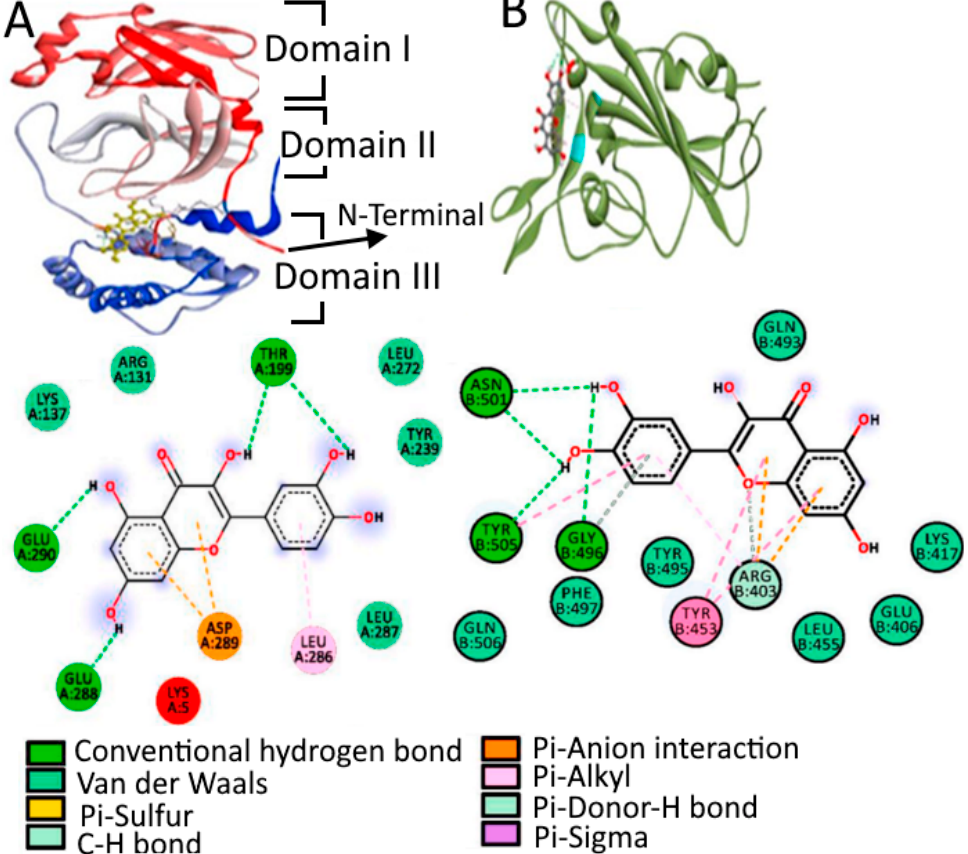
Figure 6. ( A ) Binding mode of M pro with quercetin via amino acid interactions and ( B ) binding mode of spike protein and quercetin via amino acid interactions. Adapted with permission from Vijai kumar et al. [113].